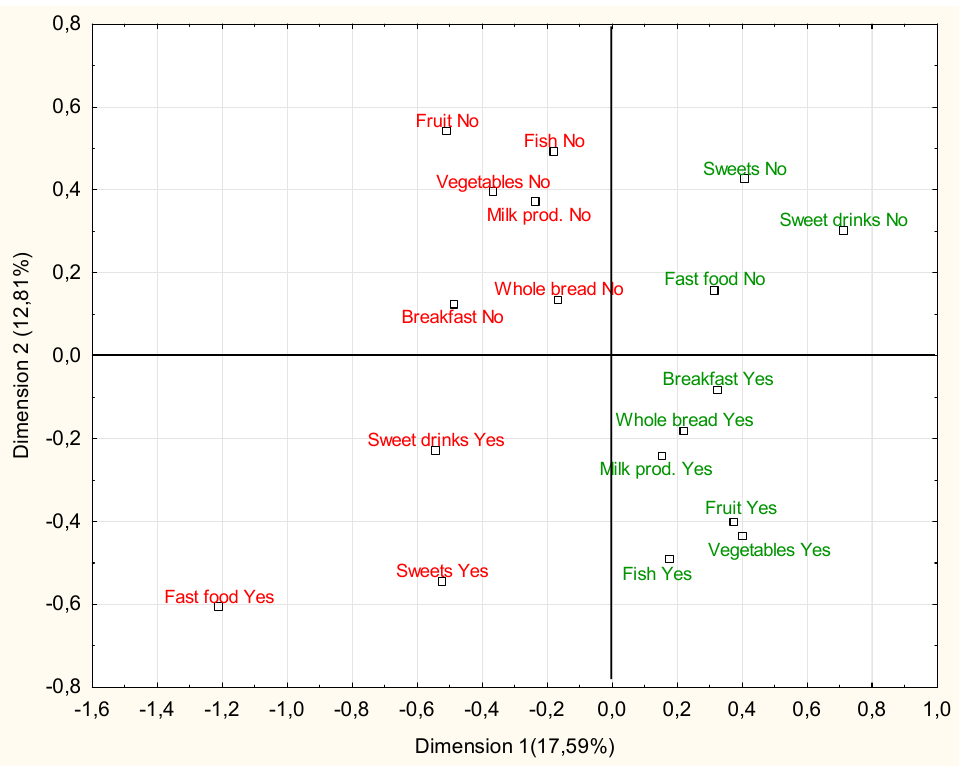
Figure 1. The results of the analysis of correspondence of all examined variables (nutritional behaviors) in the total group. Behaviors beneficial to the overall diet quality are marked in green; unfavorable behaviors are marked in red.